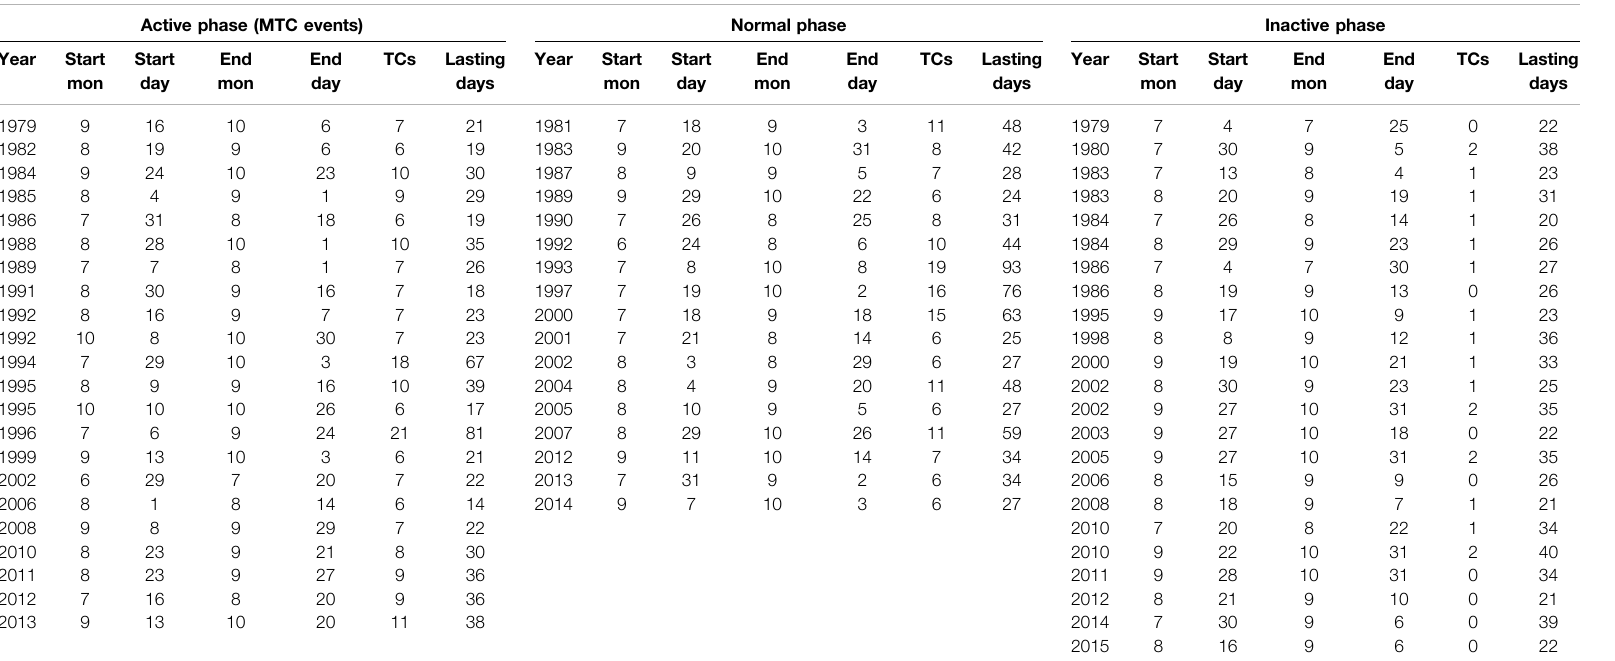
TABLE 2 | Typical events of the three MTC phases in the